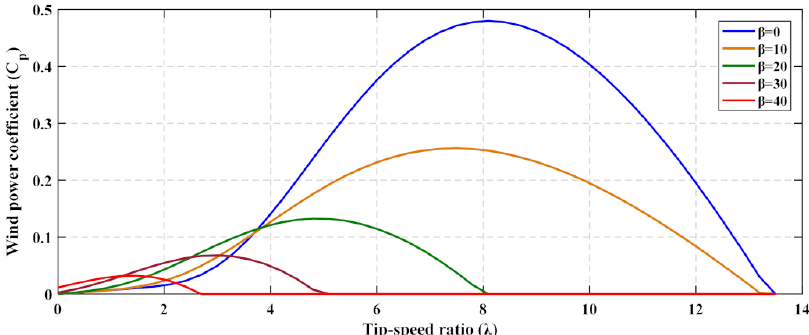
Figure 3. The relation between C p and λ at distinct values of blade pitch angles ( β ).